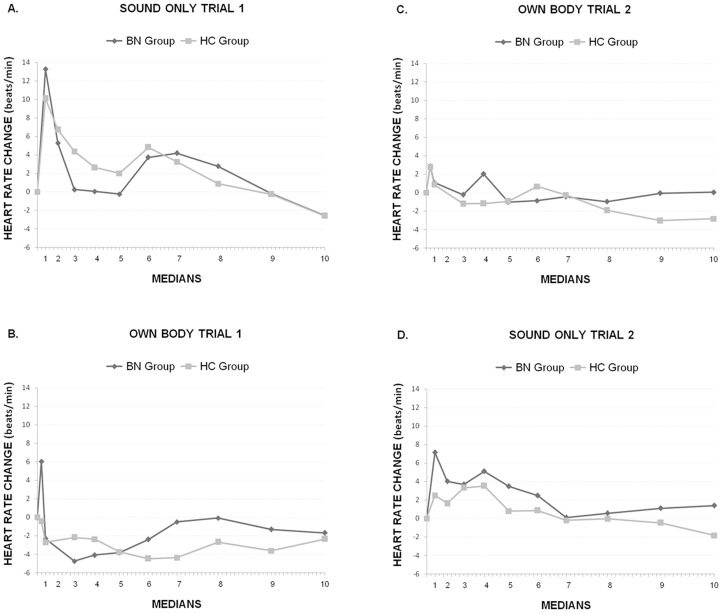
The heart-rate response to the startle-defense noise in the Bulimia (BN) and Control (CN) groups during the Sound Only trial (A) and the Own Body trial (B) presented first, and the Own Body trial (C) and the Sound Only trial (D) presented second.The typical cardiac defense response pattern was observed only in the response to the Sound Only trial presented first (A). In the Own Body trial presented first, the healthy control (HC) group showed no response, whereas the bulimia nervosa (BN) group showed the initial acceleration-deceleration pattern followed by a return to baseline (B). When both trials were presented second, the response pattern did not appear (C and D).